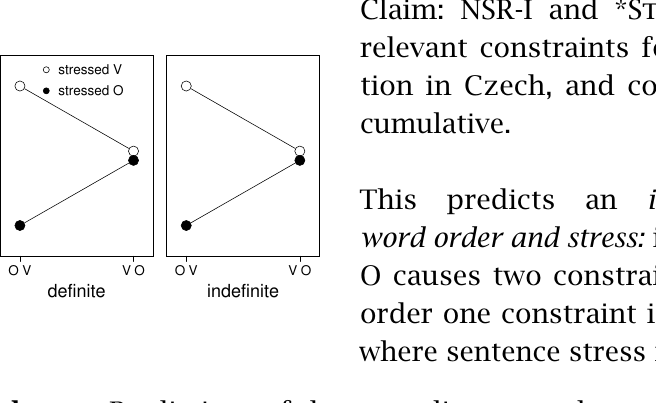
Predictions of the prosodic